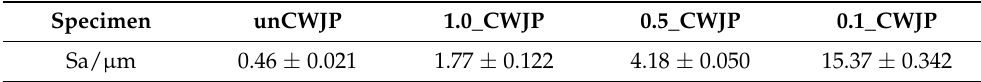
Figure 2. Three-dimensional morphology of the specimen surface at different scanning speeds. ( a ) unCWJP; ( b ) 1.0_CWJP; ( c ) 0.5_CWJP; ( d ) 0.1_CWJP. Table 2. Surface roughness of specimens at different scanning speeds.